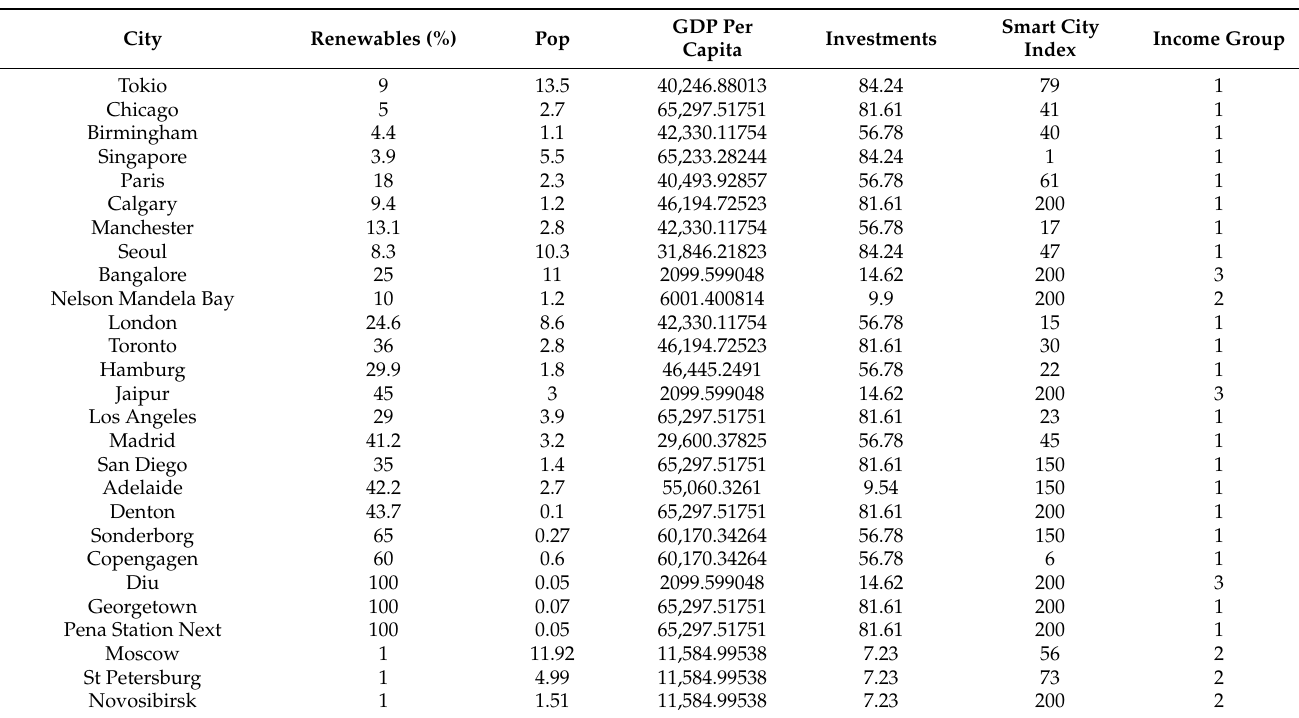
Table A1. Data for cluster